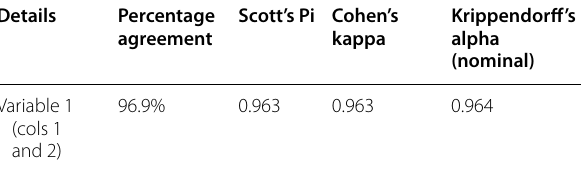
Table 2 Intercoder reliability